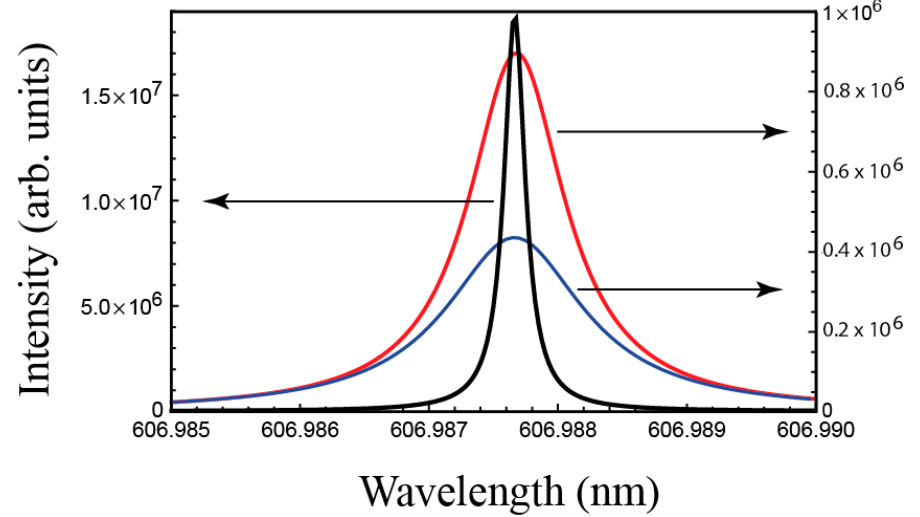
Figure 2. Emitted intensity spectrum of a simple CLC layer calculated for the first EM with three increasing γ || values: 9.89 × 10 − 4 (red curve), 9.91 × 10 − 4 (black curve), and 9.93 × 10 − 4 (blue curve). Red and blue curves were represented in a different scale (right ordinate axis) for clarity.